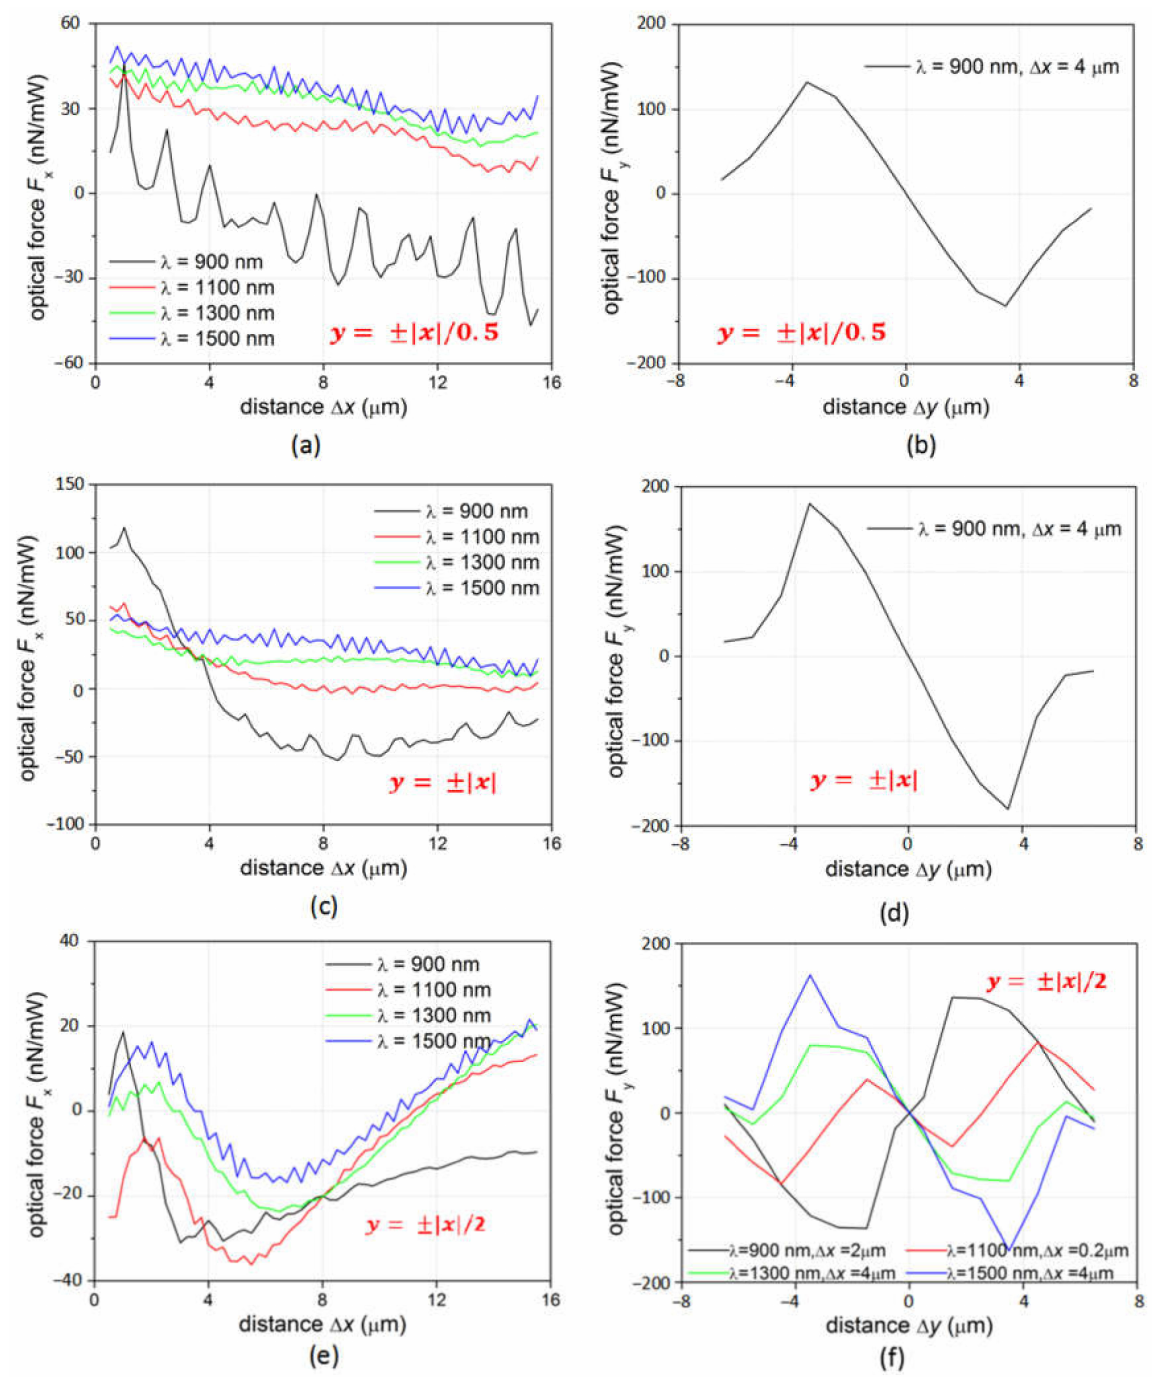
Figure 5. ( a ) The x -component of the optical force F x and ( b ) the y -component of the optical force F y by fiber y = ± | x |/0.5; ( c ) F x and ( d ) F y by fiber y = ± | x |; ( e ) F x and ( f ) F y by fiber y = ± |x| /2 on the microsphere at different incident